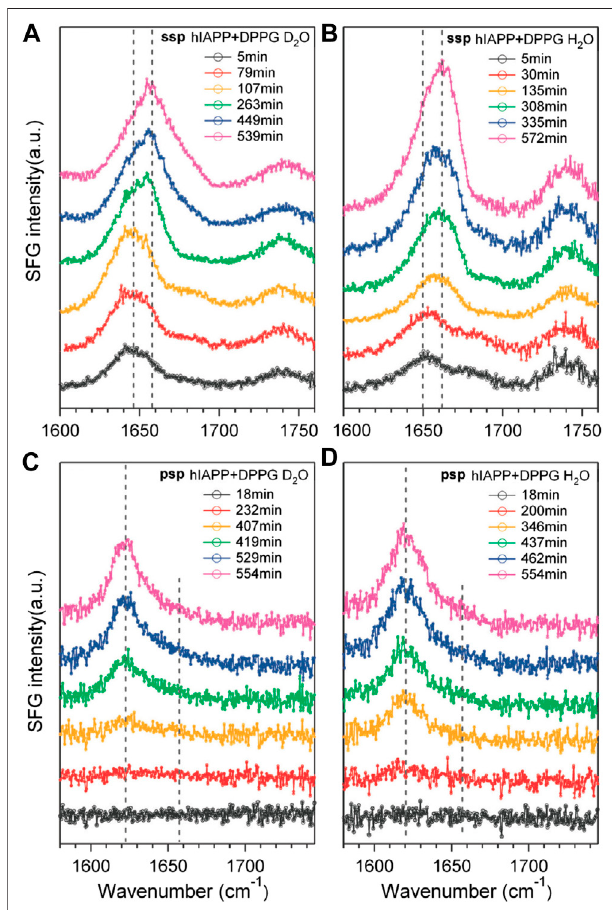
FIGURE 13 | Time-dependent spectra of hIAPP taken using the ssp polarization in the presence of DPPG at the (A) air/D 2 O and (B) air/H 2 O interfaces. The time-dependent spectra of hIAPP taken using the psp polarization in the presence of DPPG at the (C) air/D 2 O and (D) air/H 2 O interfaces.The fi gureandcaptionhavebeen adaptedwithpermissionfromFu et al., (2010), Copyright © 2010 American Chemical